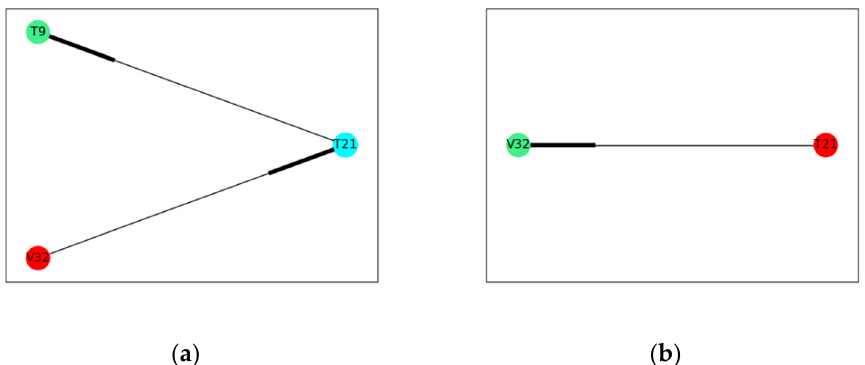
Figure 13. ( a ) Fault propagation digraph of fault 14; ( b ) fault propagation digraph of fault 17.